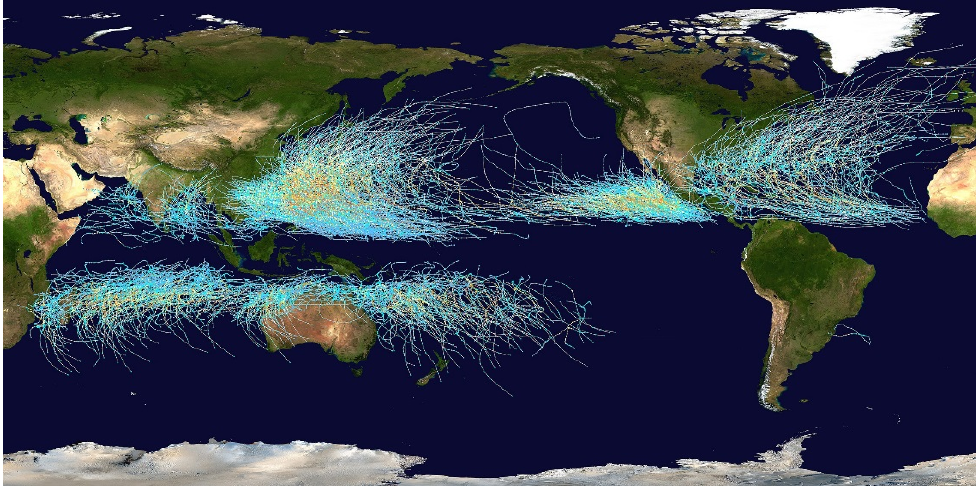
Figure 45. NASA map of the cumulative tracks of all tropical cyclones during the 1985–2005 time period [155] . Track colour indicates storm intensity.